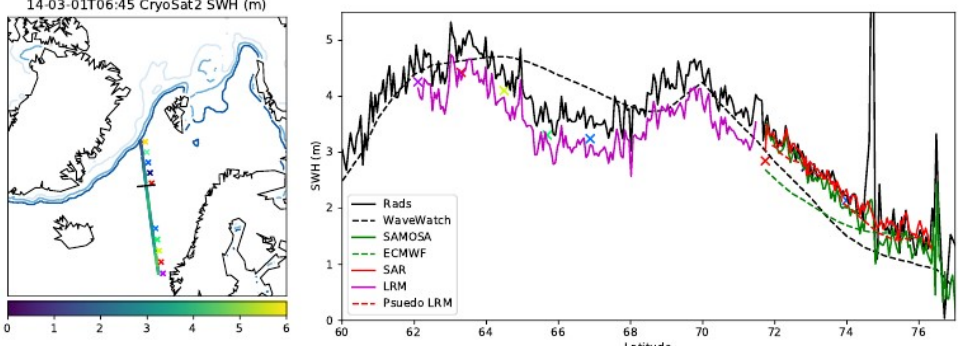
Figure 2. Significant wave height and ice concentration 6 September 2014 12:11. To the left is the map of the Arctic with NSIDC ice concentration contours of 15%, 50% and 85%. We plot our retrieved SWH from SAR and LRM modes, with the transition indicated by the black line. The coloured crosses correspond to the location of the echoes plotted in Figure 1. To the the right is the detailed SWH for the track from our new data (SAR and LRM modes), RADS (pseudo-LRM and LRM modes), SAMOSA (SAR mode) and the WaveWatch 3 and ECMWF wave